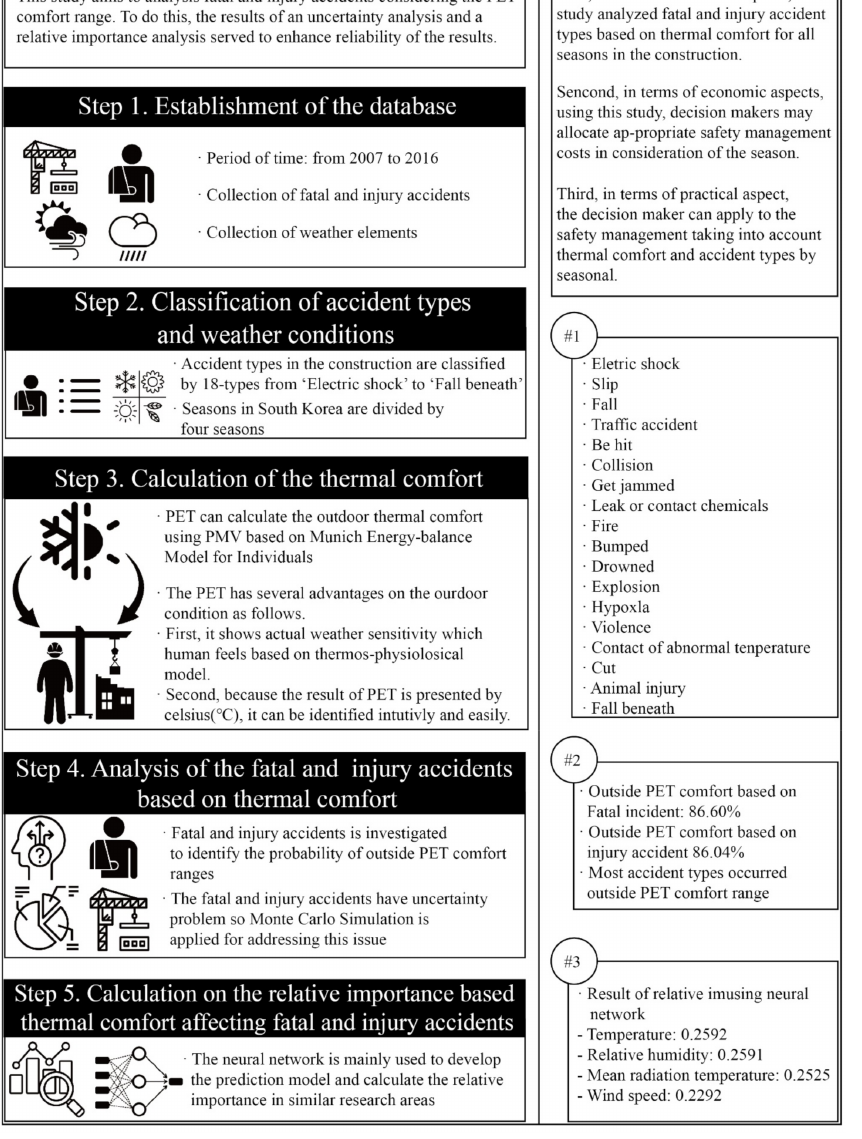
Figure 1. Research